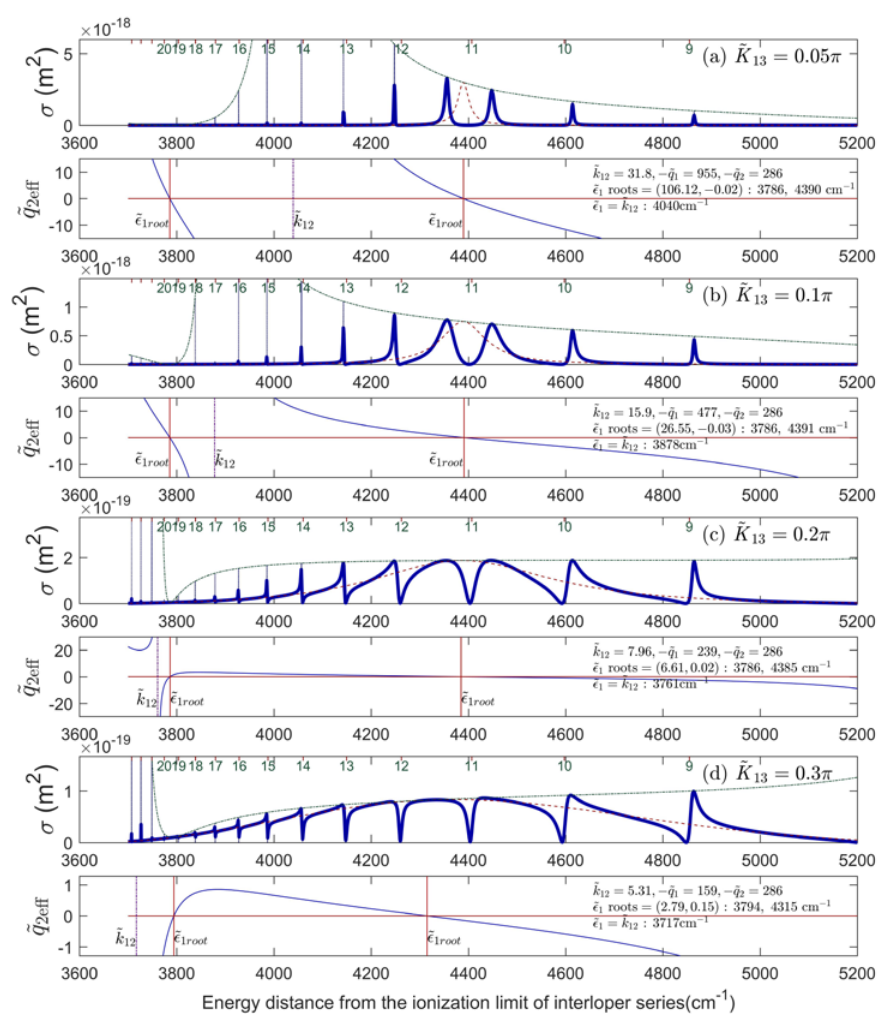
Figure 2. Effects of the variation of the widths of an interloper on the perturbed principal Rydberg series. The spectra of the interloper itself are also shown with a dotted line. (cid:101) K 13 / π = 0.05, 0.1, 0.2, 0.3 from the above (from [13]).